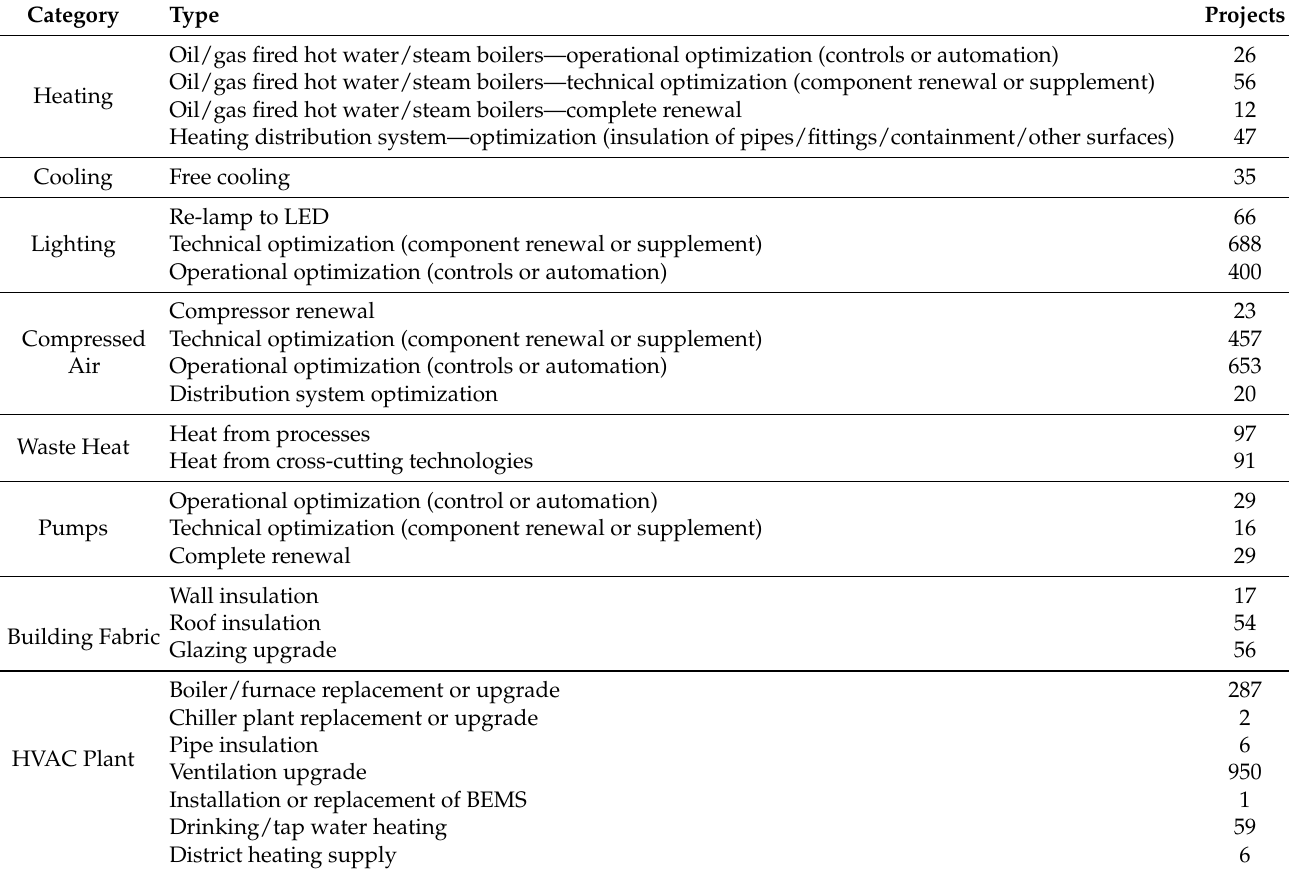
Table 1. The formulated investment categories and investment types per category for the EE investments used in the case study. For each type of investment, the number of available projects is also